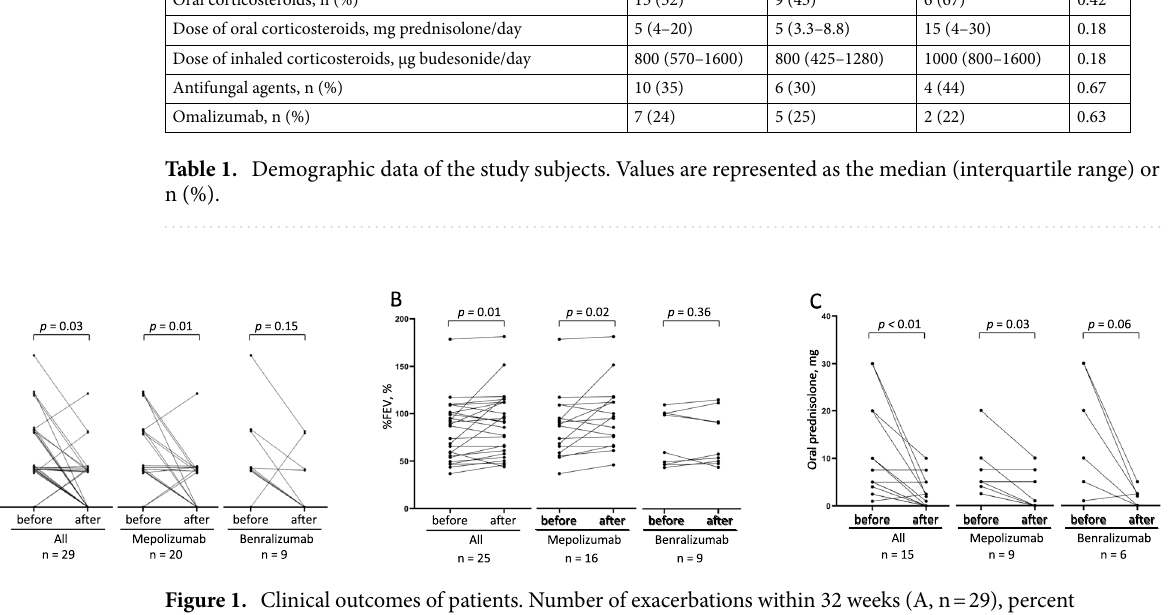
Figure 1. Clinical outcomes of patients. Number of exacerbations within 32 weeks (A, n = 29), percent forced expiratory volume in one second (FEV 1 ) of predicted values (B, n = 25), and dose of oral prednisolone (C, n = 15) before and after initiating treatment with mepolizumab or benralizumab in patients with allergic bronchopulmonary aspergillosis complicated by asthma. Treatment with mepolizumab or benralizumab significantly reduced exacerbation rate and oral corticosteroid dose, and improved pulmonary